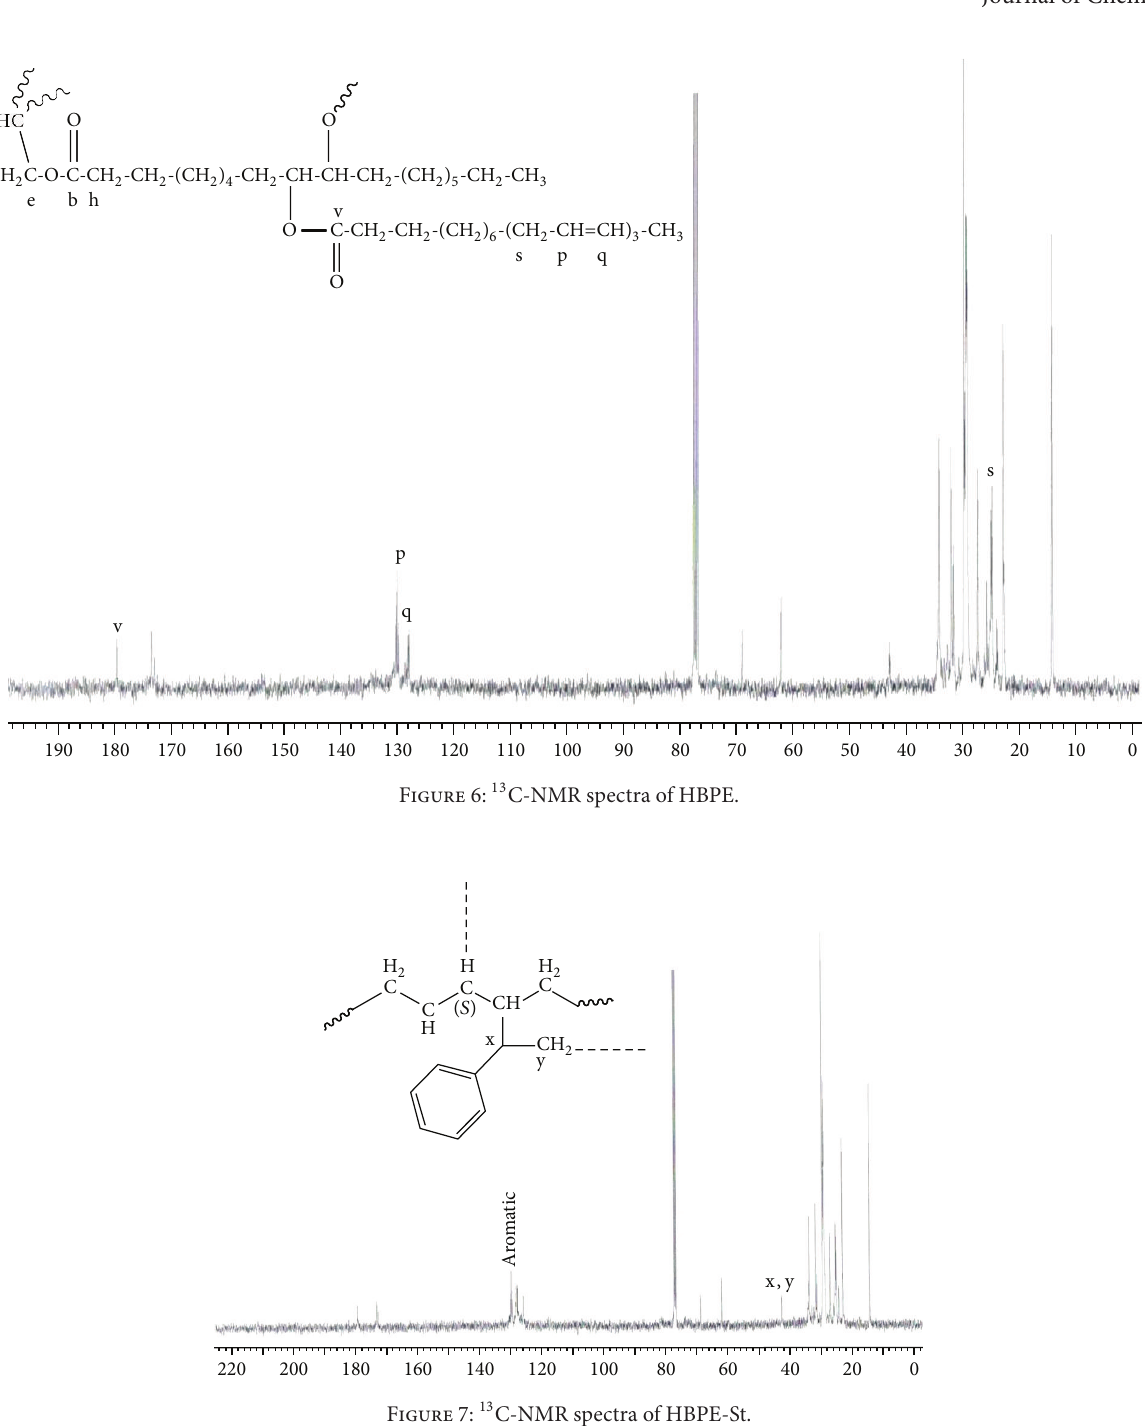
Figure 7: 13 C-NMR spectra of